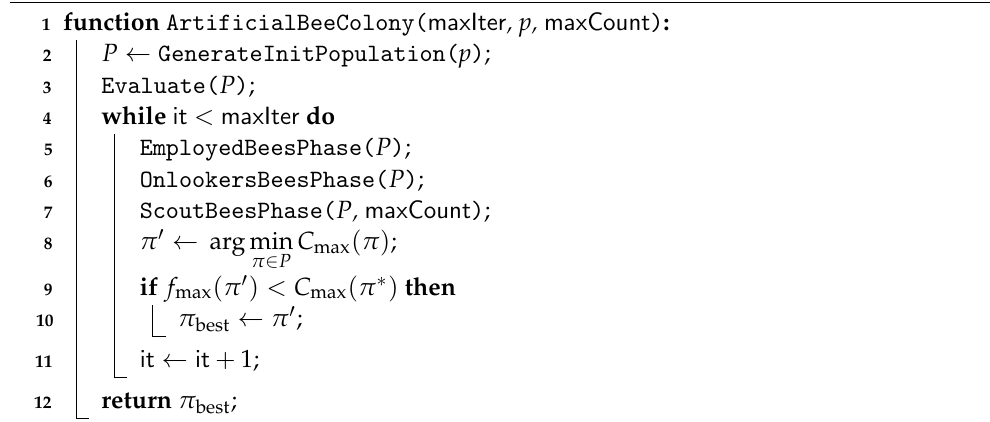
Algorithm 1: Artificial bee colony (method outline).